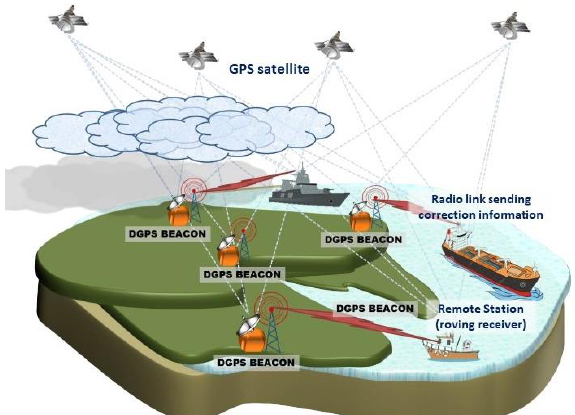
Figure 1. DGPS application concept